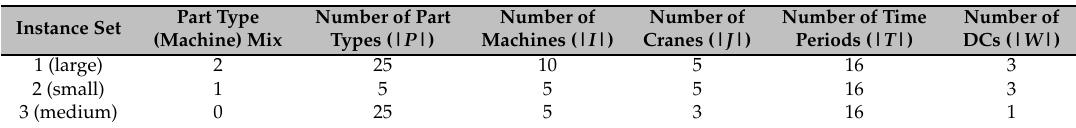
Table 1. Description of problem test instance sets.